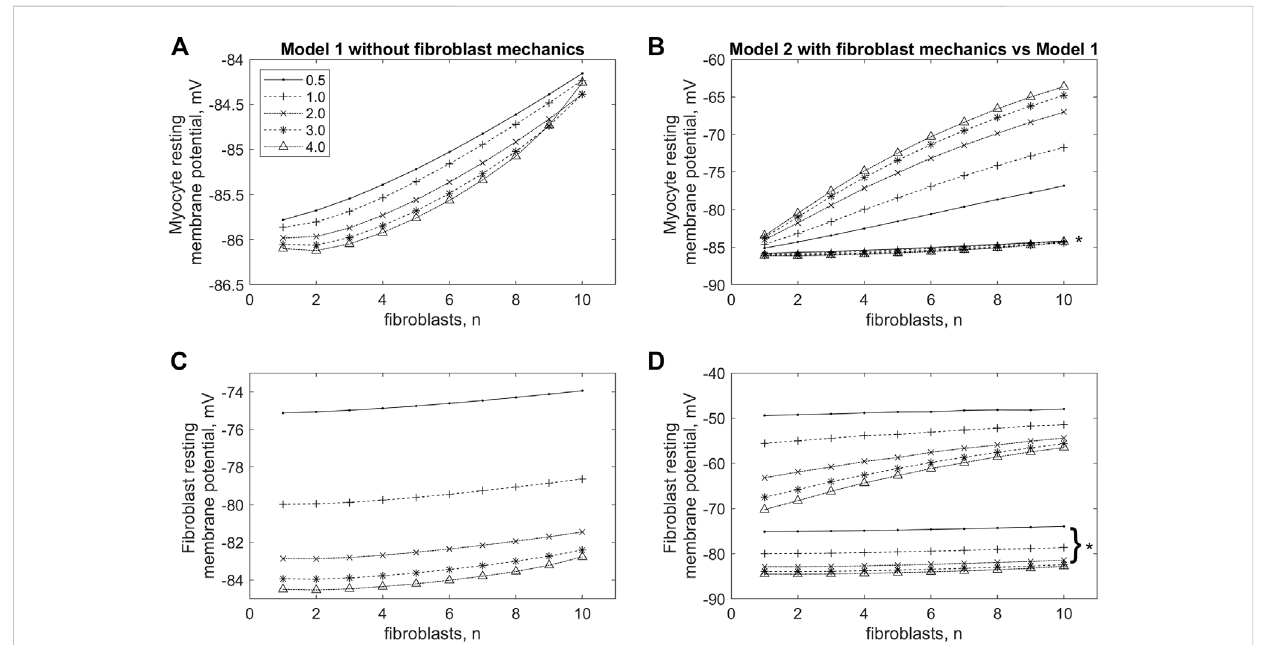
FIGURE 4 Changes in resting membrane potential in cardiomyocyte (A,B) and fi broblasts (C,D) in model 1 , in which the mechano-dependence of fi broblast activity is not considered (A,C) , and in model 2 if compared with model 1 (B,D) with increasing numbers of fi broblasts ( n ) and values of intercellular conductance between fi broblasts and myocytes ( ɡ gap ). The lines marked with asterisks in panels (B,D) are the same as those shown in panels (A,C) for model 1, but shown at the same scale as the lines for model 2